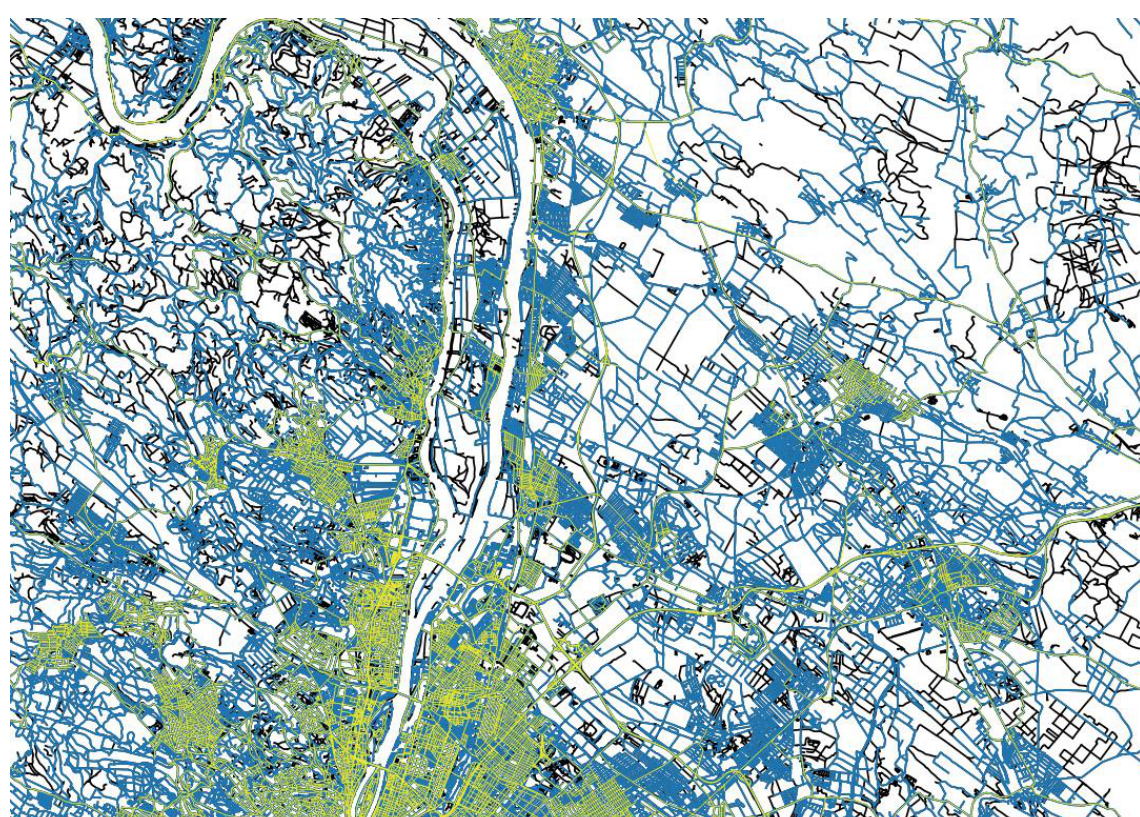
Figure 4. Evolution of the road network density near Budapest in years 2010 (yellow), 2015 (blue) and 2018